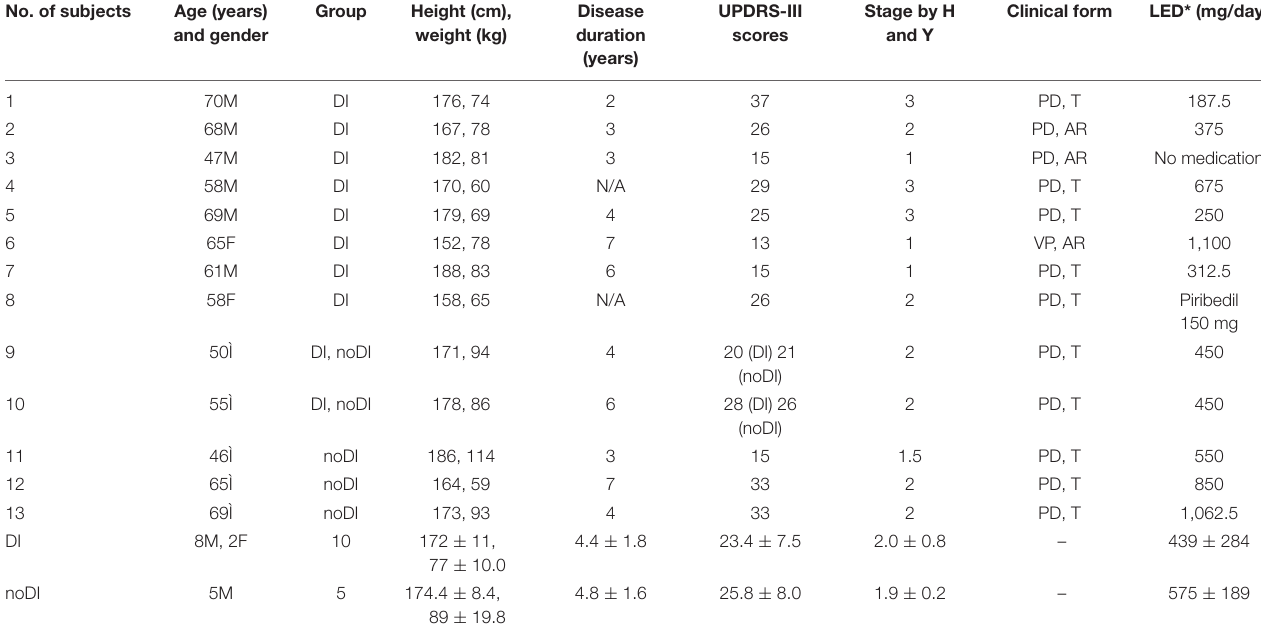
TABLE 1 | The anthropologic and clinical data on the subjects with PD.